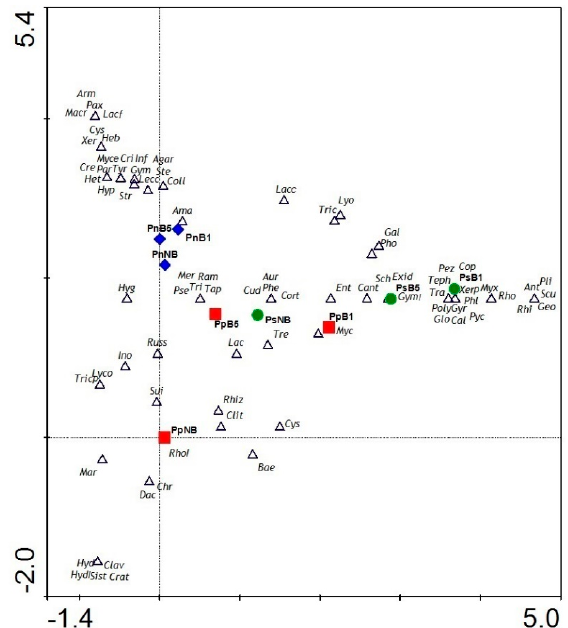
Figure 2. Detrended correspondence analysis for the three different study sites. Pp (red square): Pinus pinaster forests growing under wet Mediterranean conditions; Pn (blue diamond): Pinus nigra forests growing under dry Mediterranean conditions; Ps (green circle): Pinus sylvestris forests growing under boreal conditions. NB: non-burned; B1: one year after fire; B5: five years after fire. Taxa are marked using the codes shown in Table